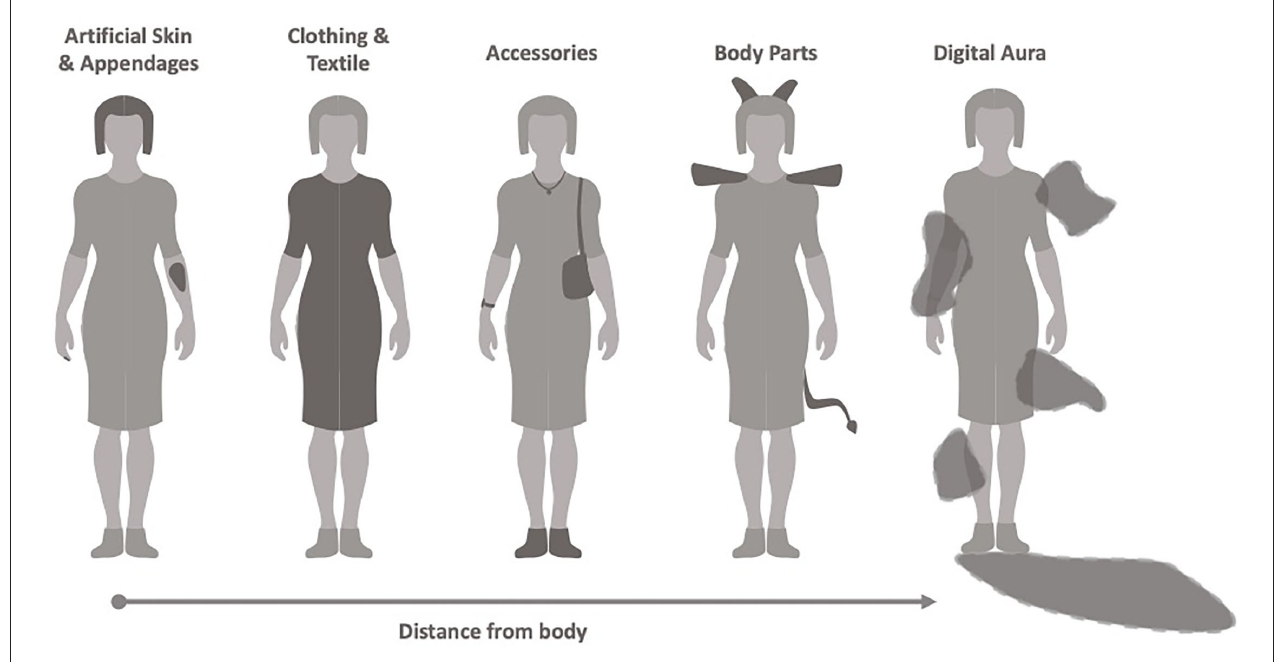
FIGURE 1 | Categorization of appearance augmentation